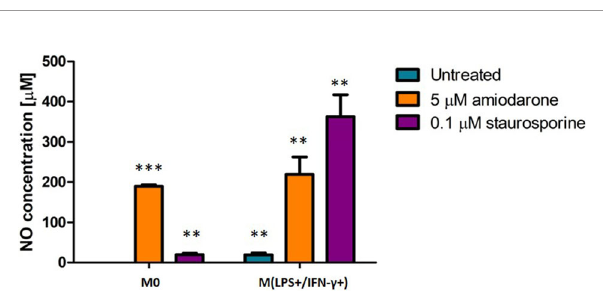
FIGURE 4 | Effect on NO production in non-activated (M0) and LPS/IFN- g activated NR8383 rat macrophages after 24 h exposure to 5 µM amiodarone (orange bars) and 0.1 µM staurosporine (purple bars). Data are normalized to cell count and presented as mean values ± SEM of four separate experiments. Statistical comparisons are made using a one-way ANOVA analysis with Bonferroni ’ s multiple comparison post-hoc test. Results are compared to non-polarized control (M0); **indicate p < 0.01 and *** indicates p <